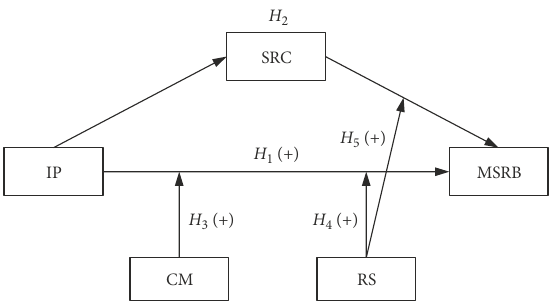
Figure 1. Conceptual model of MSRB rules